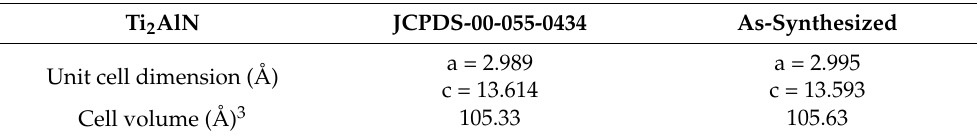
Figure 2. ( a ) XRD pattern, ( b ) FE–SEM image, and ( c ) Raman spectrum of as-synthesized Ti 2 AlN MAX phase. Table 1. Crystallographic details on structural determination of as-synthesized Ti 2 AlN MAX